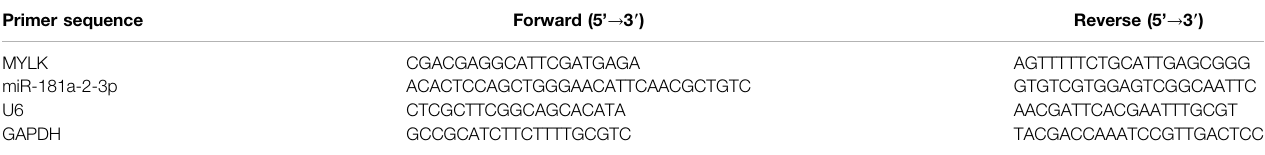
TABLE 1 | Primer sequences in